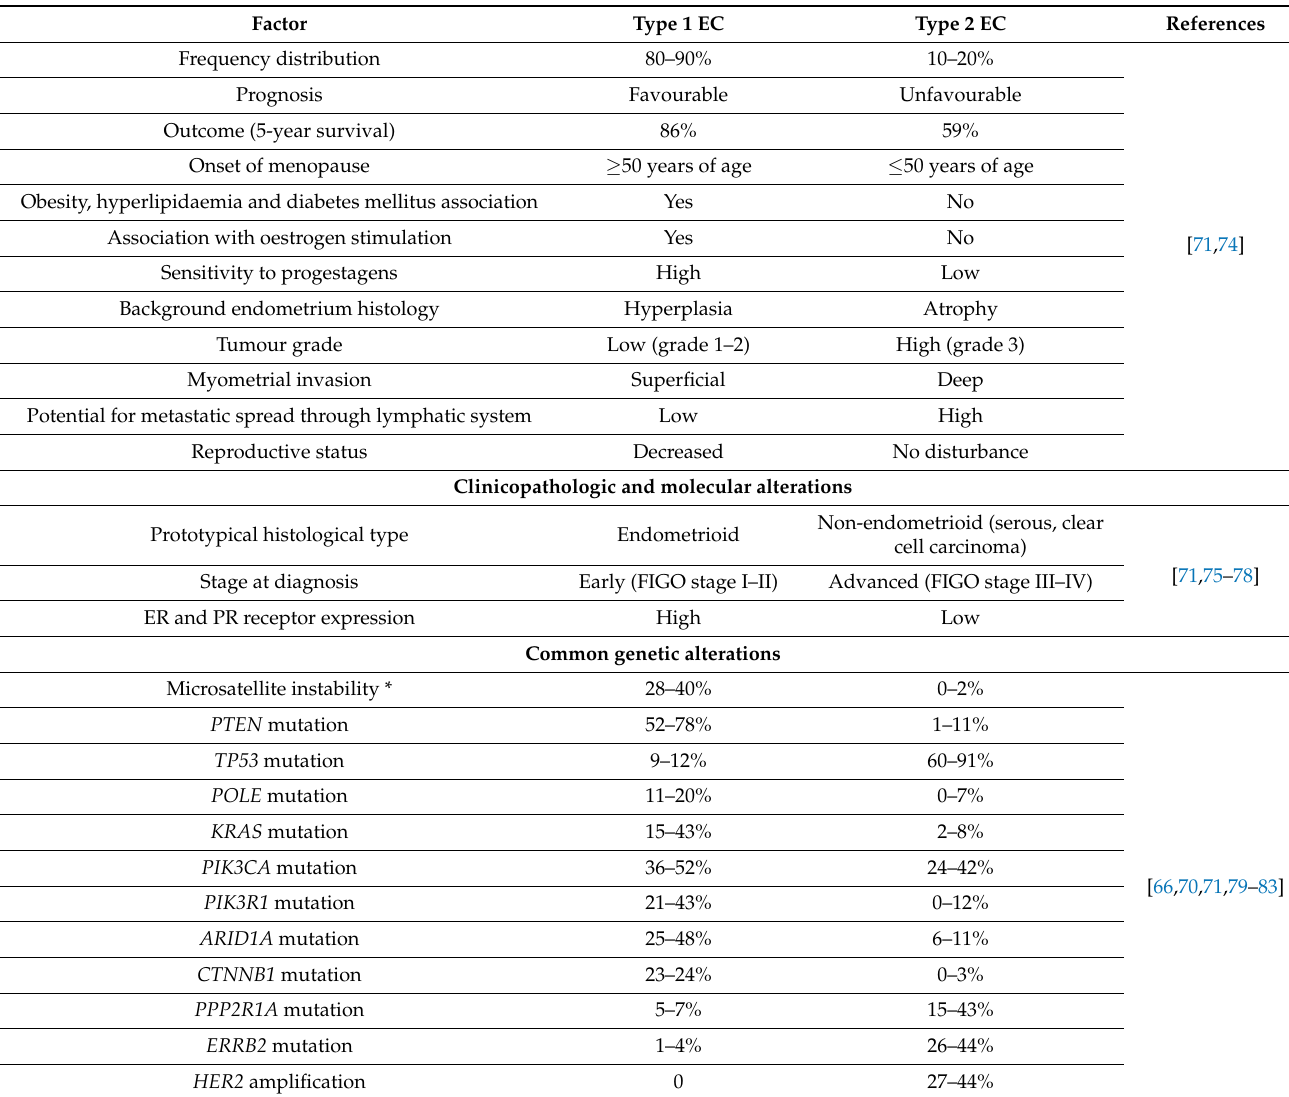
Table 2. Pathological, morphological, endocrine and common molecular genetic changes used to provide a dualistic clinical classifica- tion of endometrial cancers (Bokhman Classification).